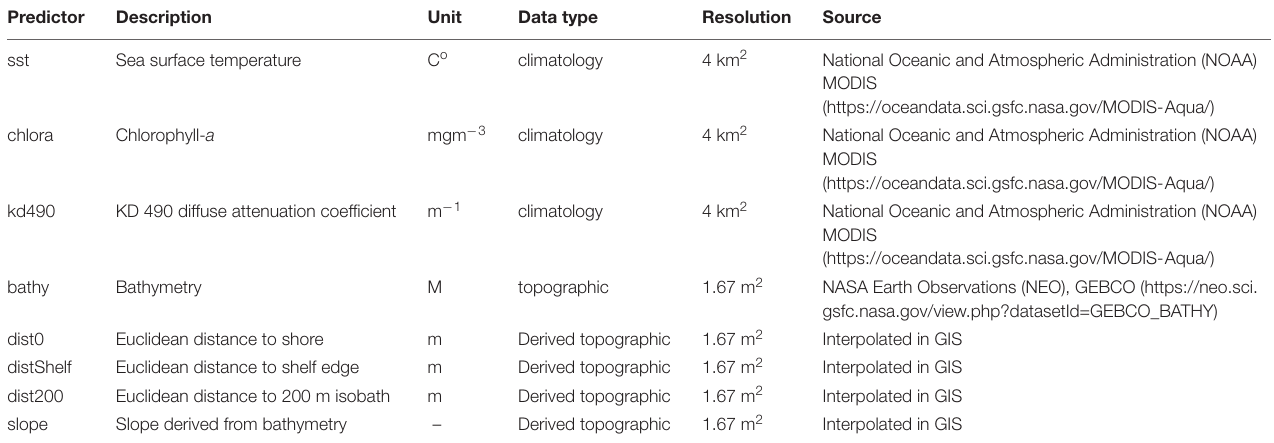
TABLE 2 | Candidate environmental variables used in model selection